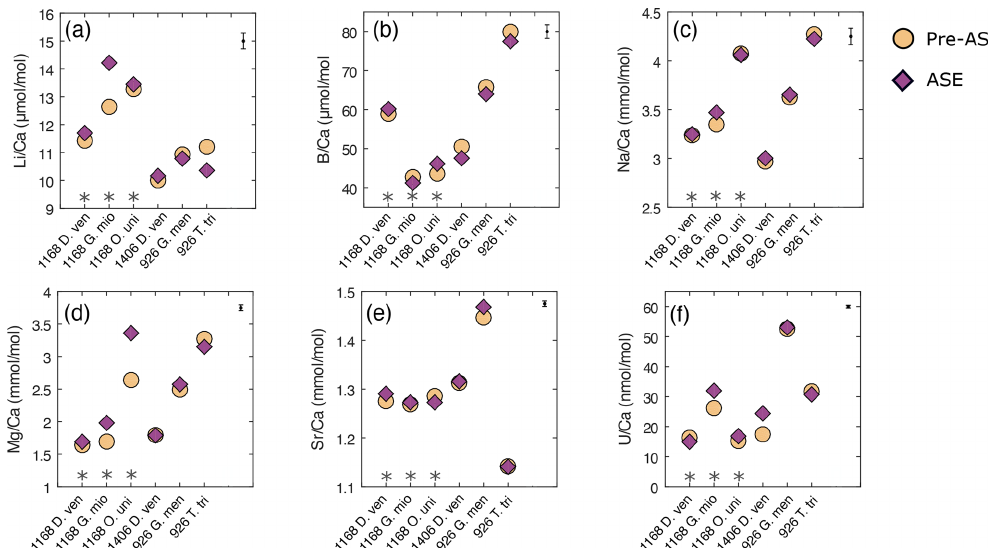
Figure 4. Results of trace element analyses for pre-ASE (yellow circles) and ASE (purple diamonds) for the species from the core sites studied. Uncertainty in the average sample value for each element is shown in the upper right-hand corner. No systematic offset is observed between the treatments. (a) Li / Ca, (b) B / Ca, (c) Na / Ca, (d) Mg / Ca, (e) Sr / Ca, (f) U / Ca. D. ven.: D. venezuelana ; G. mio: G. miotumida ; O.